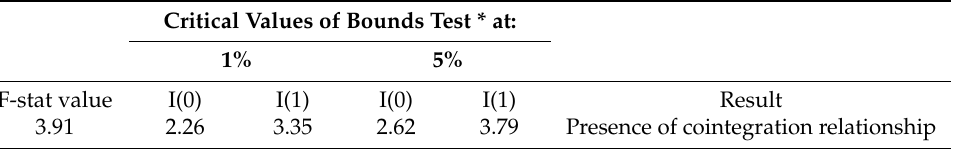
Table 3. Bounds test to